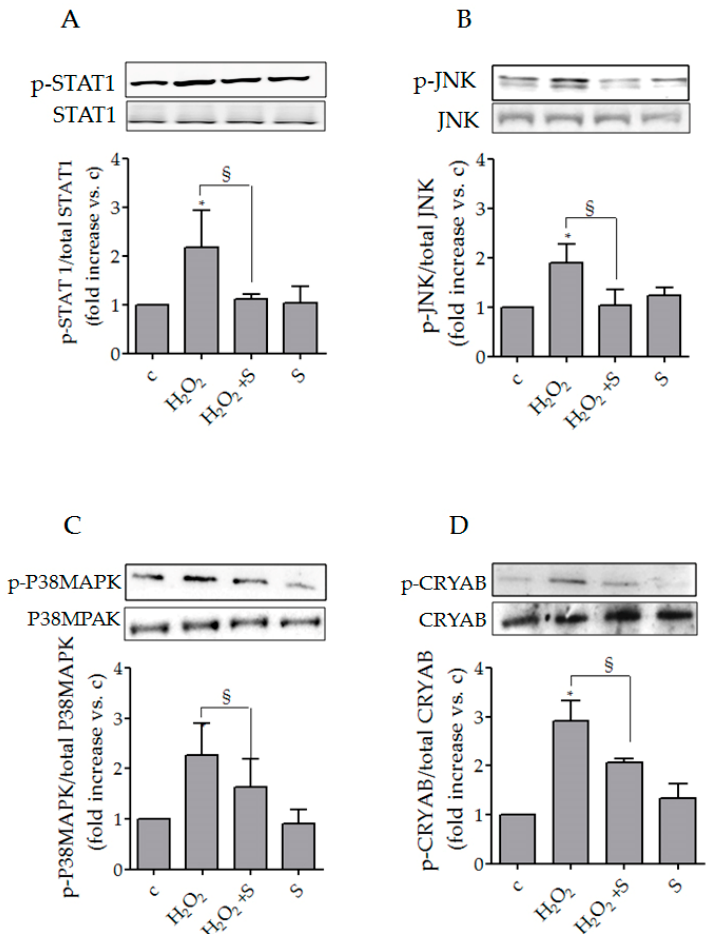
Figure 3. Representative Western blot images of proteins analyzed in SSc fibroblasts. Proteins extracted from SSc fibroblasts exposed to H 2 O 2 (100 µ M) with or without sildenafil (1 µ M) were immunoblotted with antibodies against the total and phosphorylated form of STAT1 ( A ), JNK ( B ), P38MAPK ( C ) and CRYAB ( D ). Bars of the histograms show the ratio between the phosphorylated and total forms of the protein targets. Statistical significance was determined using ANOVA with Bonferroni’s post-hoc test. * p < 0.05 vs. relative control within group; § p < 0.05. S , sildenafil. Experiments were repeated at least three times ( n = 3) with essentially identical